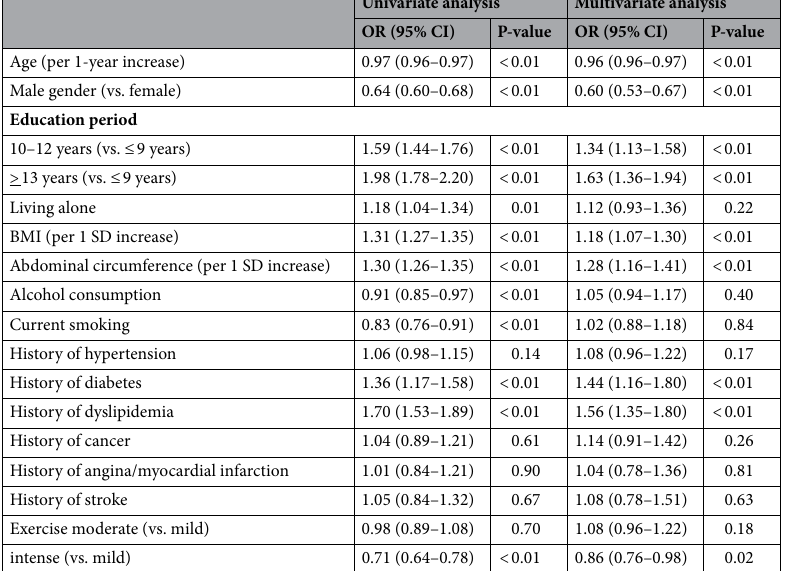
Univariate analysis Multivariate